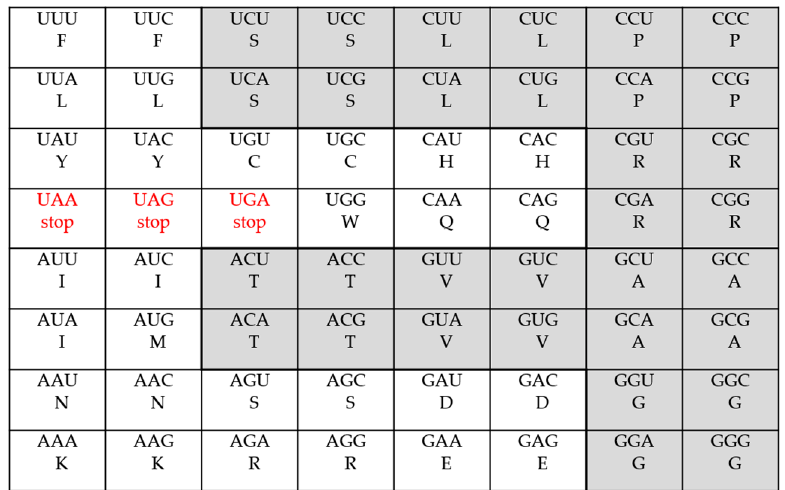
Figure 1. The standard genetic code Table.